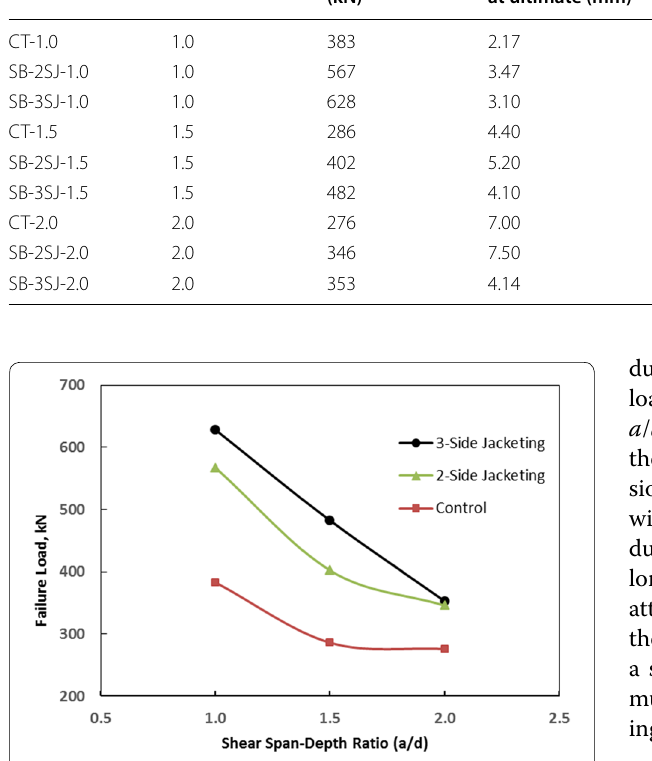
Fig. 16 Effect of a / d ratio and strengthening configuration on load‑carrying